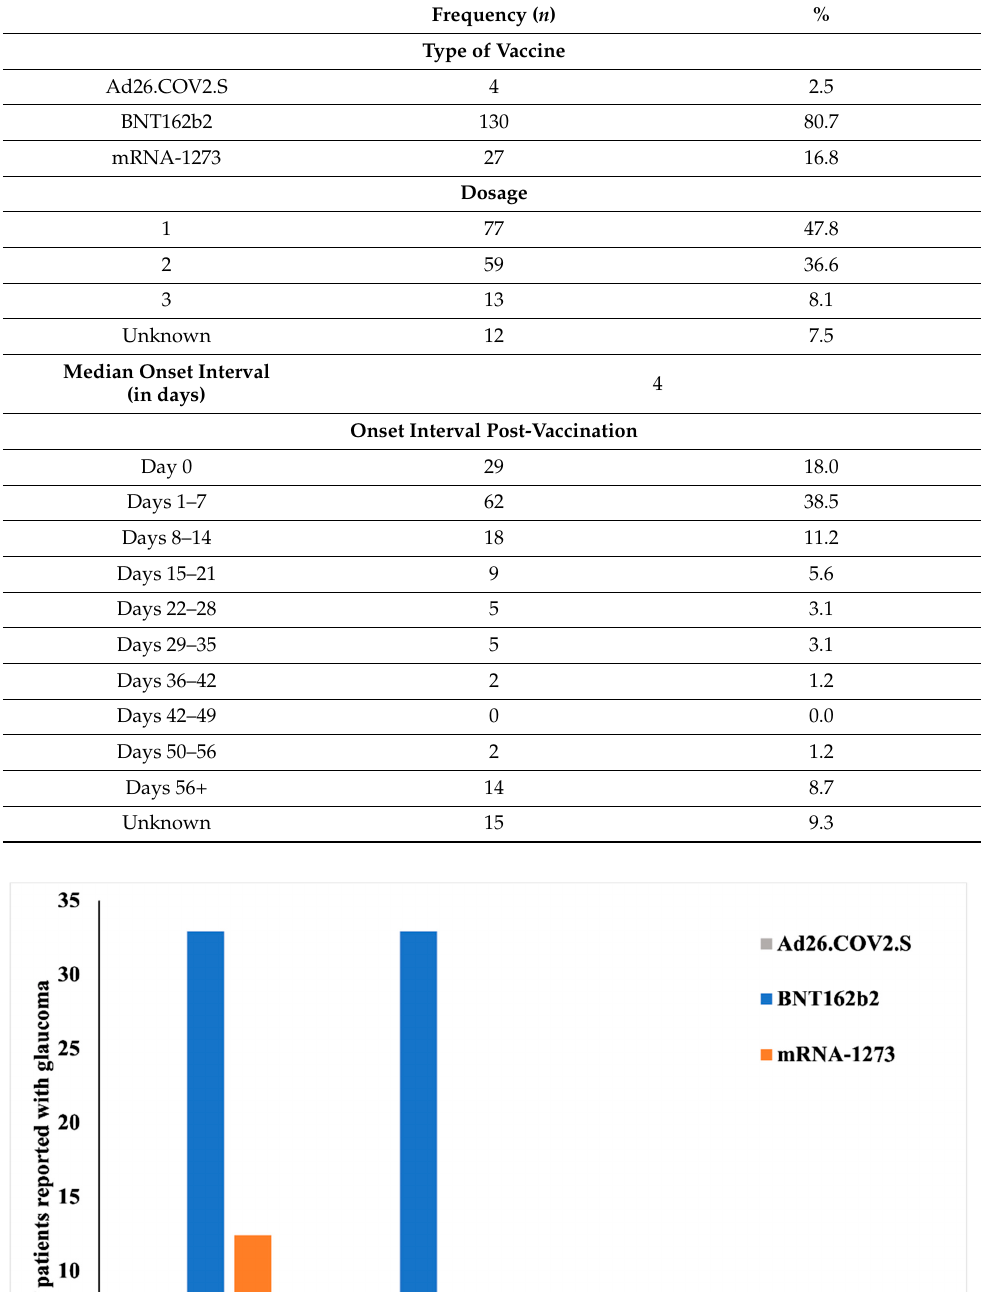
Table 2. Vaccination data of patients who were diagnosed with glaucoma following vaccination.